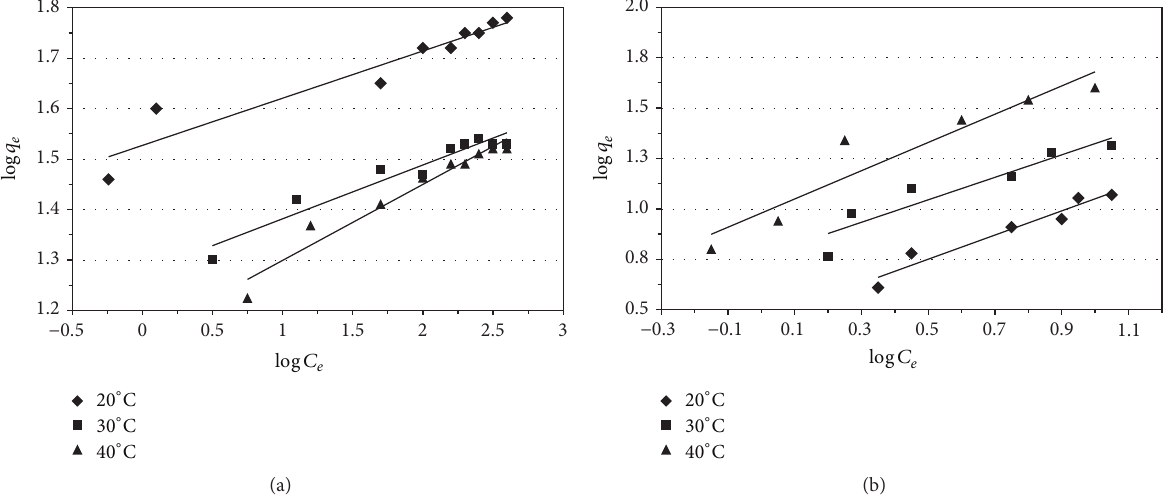
Figure 8: Freundlich isotherm of LDPO-G for fluoride and phosphate removal. (a) Removal of phosphate at 20, 30, and 40 ∘ C. (b) Removal of fluoride at 20, 30, and 40 ∘ C.